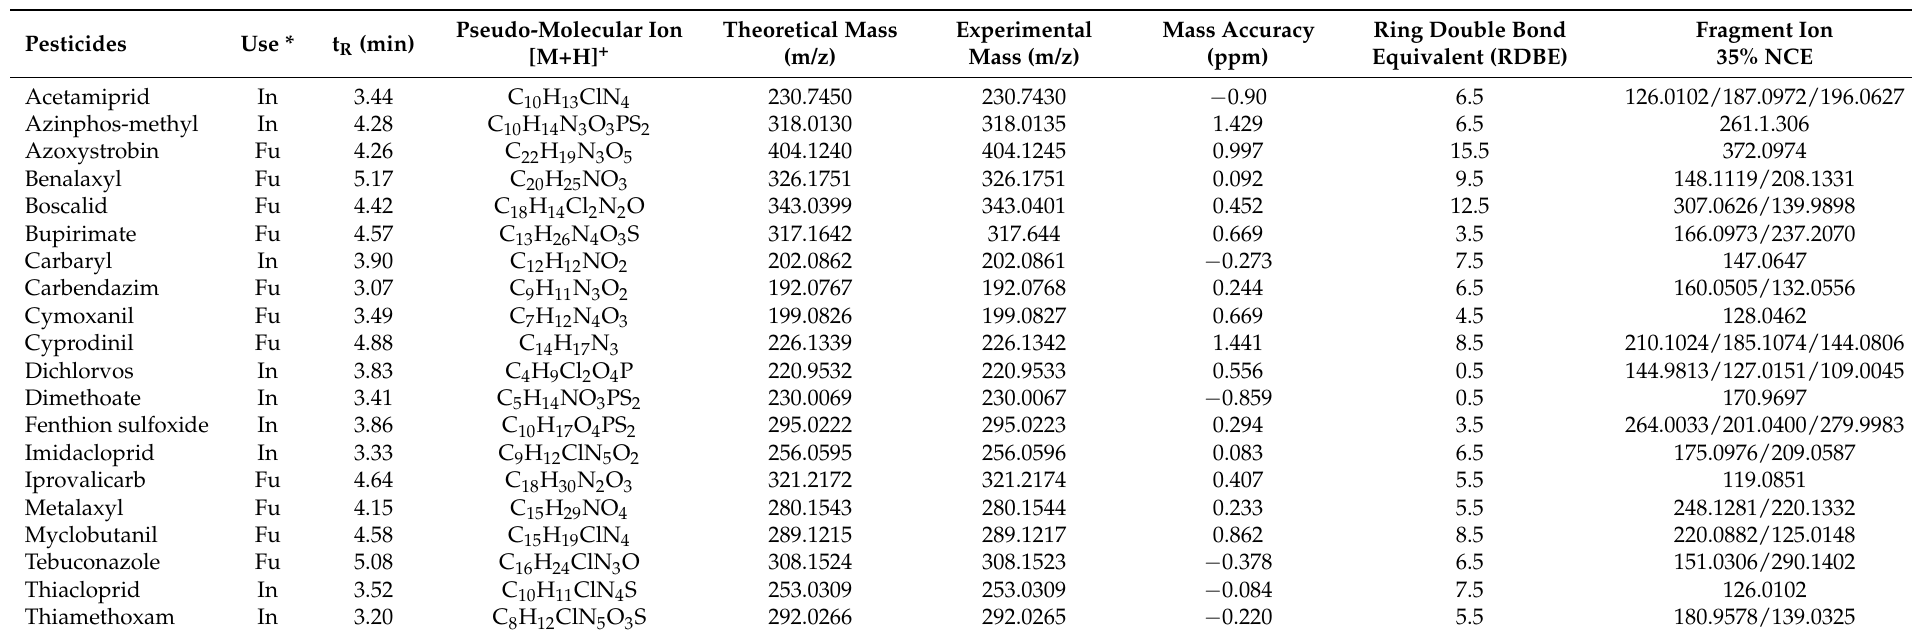
Table 1. UHPLC–LTQ Orbitrap mass spectrometry analysis data. Target pesticides, use, retention times, and parameters for full MS/dd-MS 2